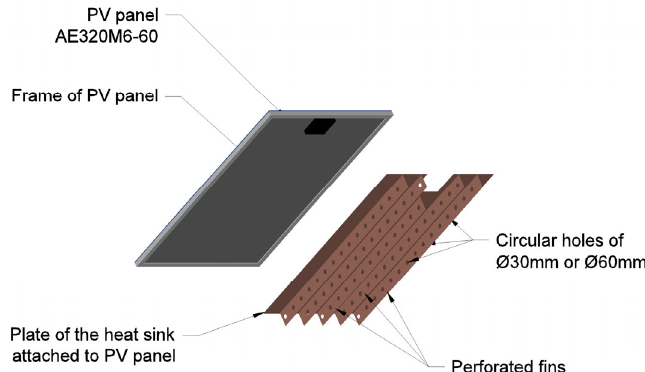
Figure 1. The PV panel—heat sink ensemble—Case of vertical fins with perforations.